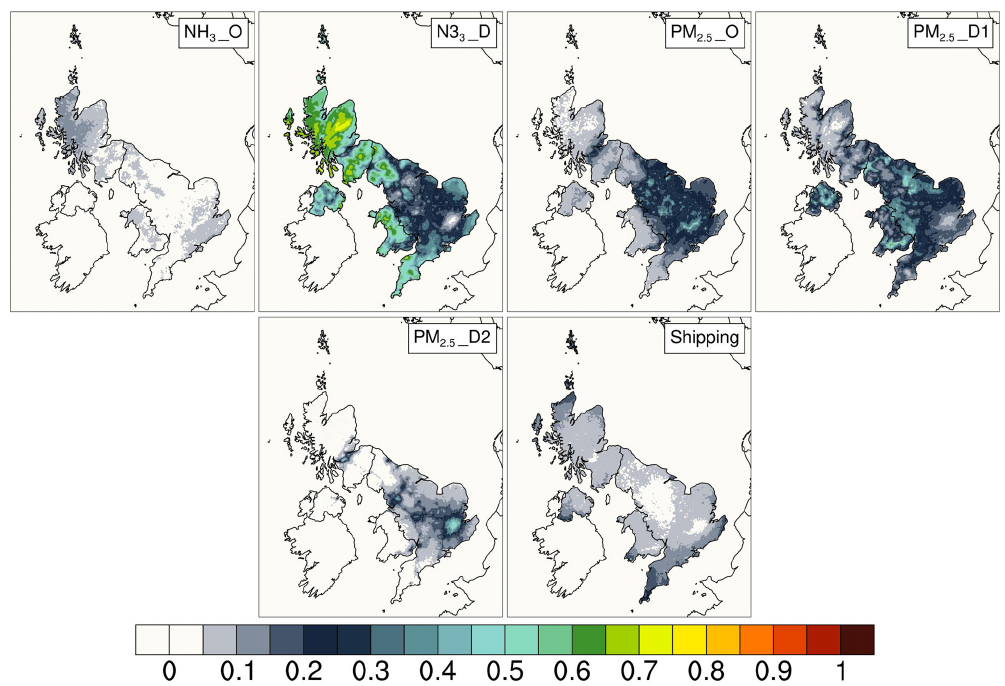
Figure 5. Spatial distributions (at the 5km × 5km model grid resolution) of the first-order sensitivity indices for modelled surface concen- trations of PM 2 . 5 . D indicates emissions from a dominant sector and O indicates grouped emissions from the rest of the sectors. For NH 3 emissions the dominant sector is agriculture, and for PM 2 . 5 the dominant sectors are residential and non-industrial combustion (D1) and road transport (D2). The shipping emissions variable combines emissions of all relevant